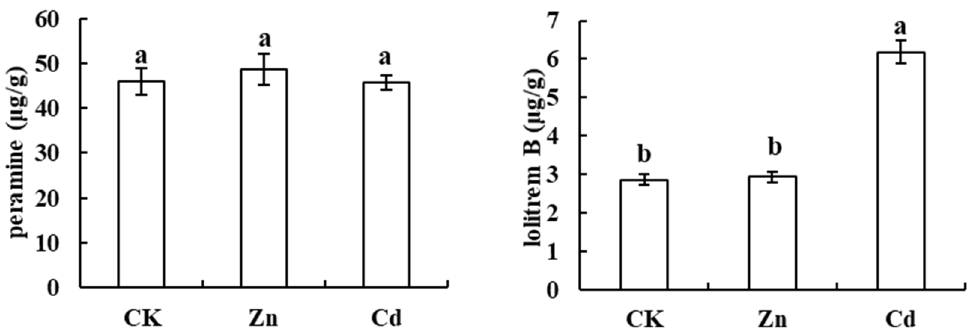
Figure 7. Peramine ( A ) and lolitrem B ( B ) concentrations of F. sinensis E+ plants under Zn 2+ and Cd 2+ treatments. Note: The left is the alkaloid peak. Different lowercase letters indicate significant differences between treatments ( p < 0.05).